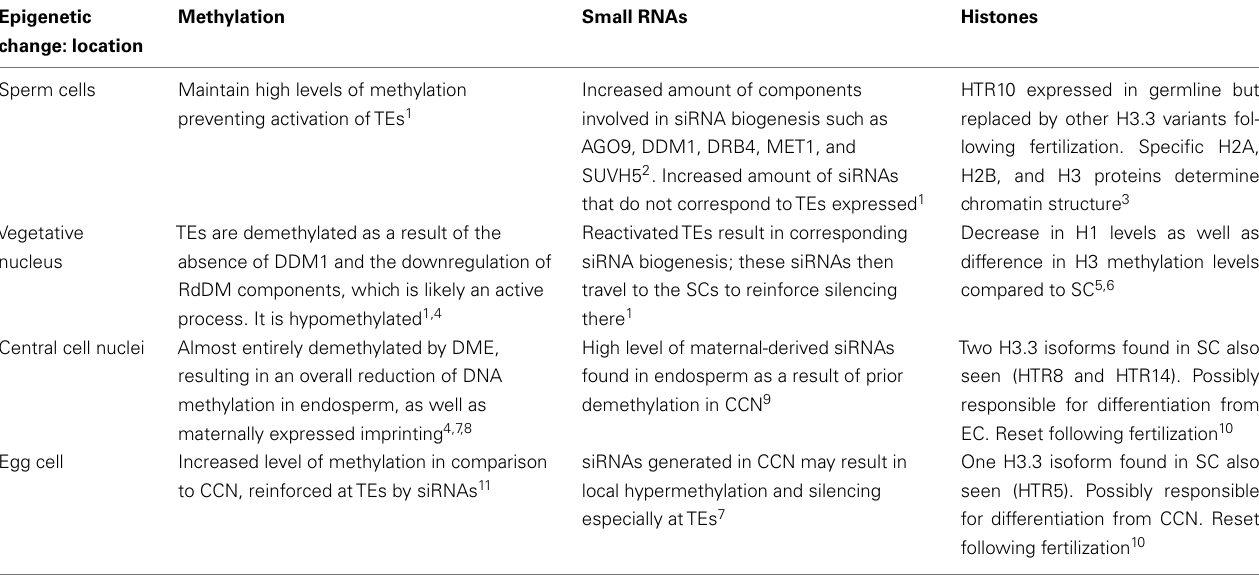
Table 3 | Summary of epigenetic changes during angiosperm